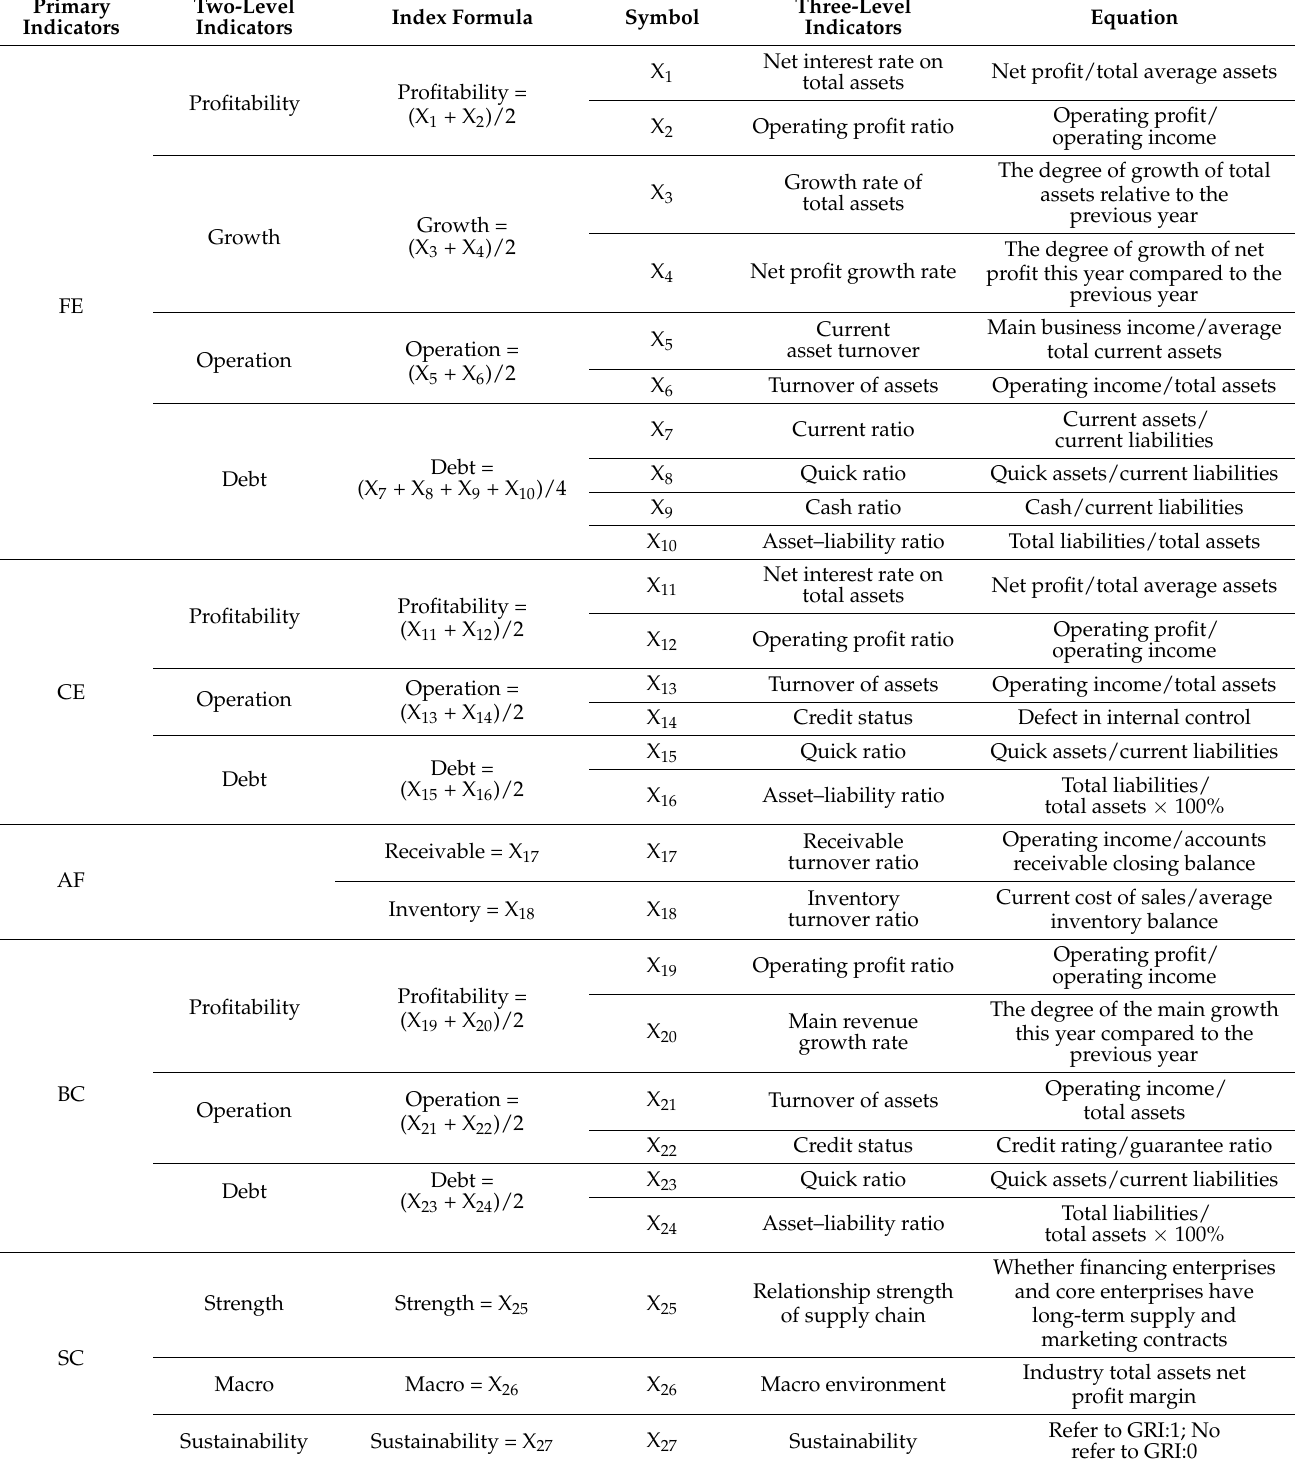
Table 2. Independent variables involved in credit risk